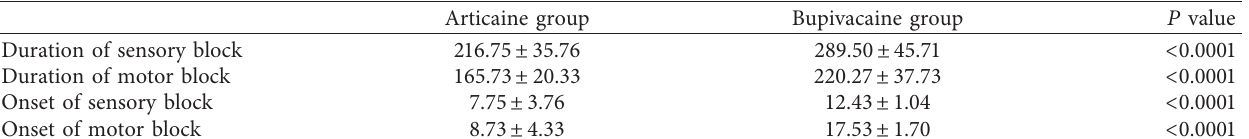
Table 2: Block character.